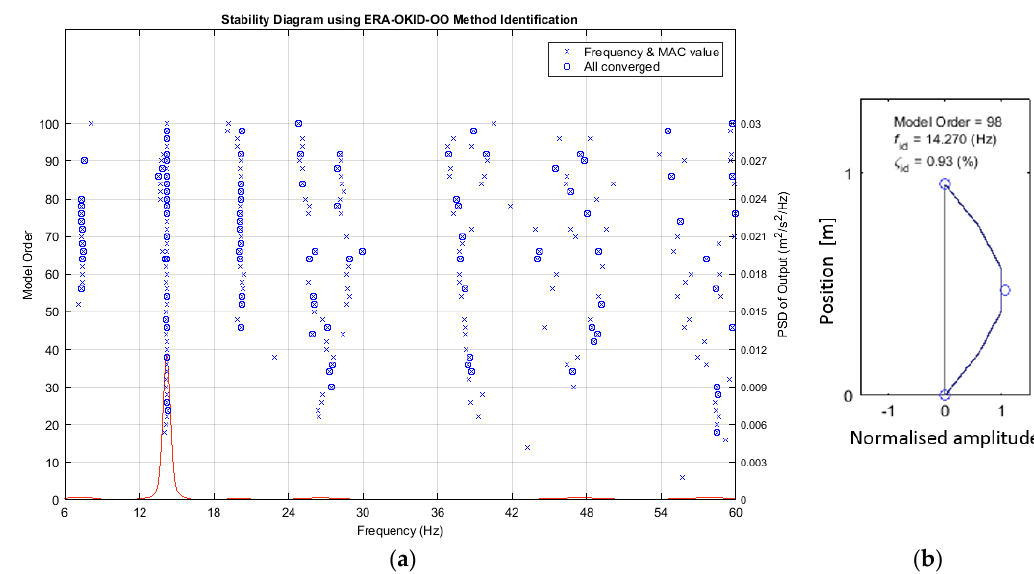
Figure 5. Experimentally derived dynamic parameters for the tested glass specimens: ( a ) fundamental frequency, ( b ) modal damping and reference vibration shape (example referred to a B-1 sample with “rigid” steel supports).